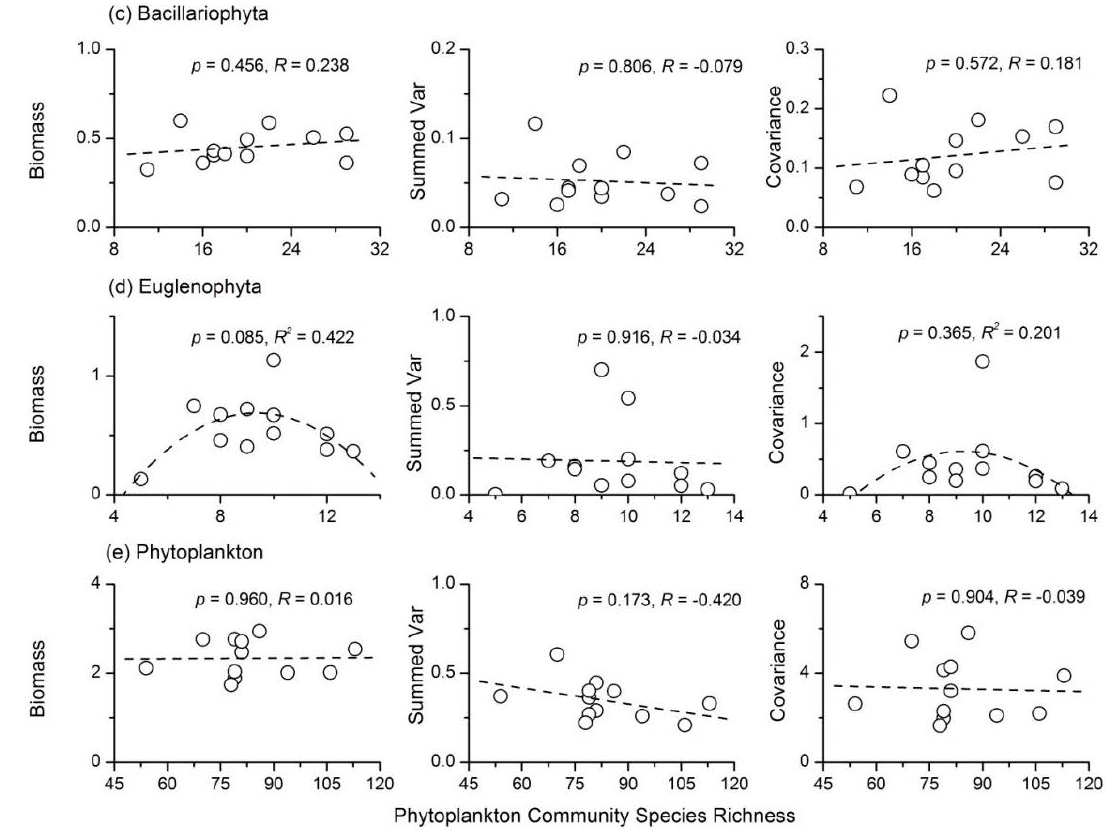
Figure 6. Relationships between species richness and the three components of community stability for ( a ) Cyanophyta; ( b ) Chlorophyta; ( c ) Bacillariophyta; ( d ) Euglenophyta and ( e ) total phytoplankton.